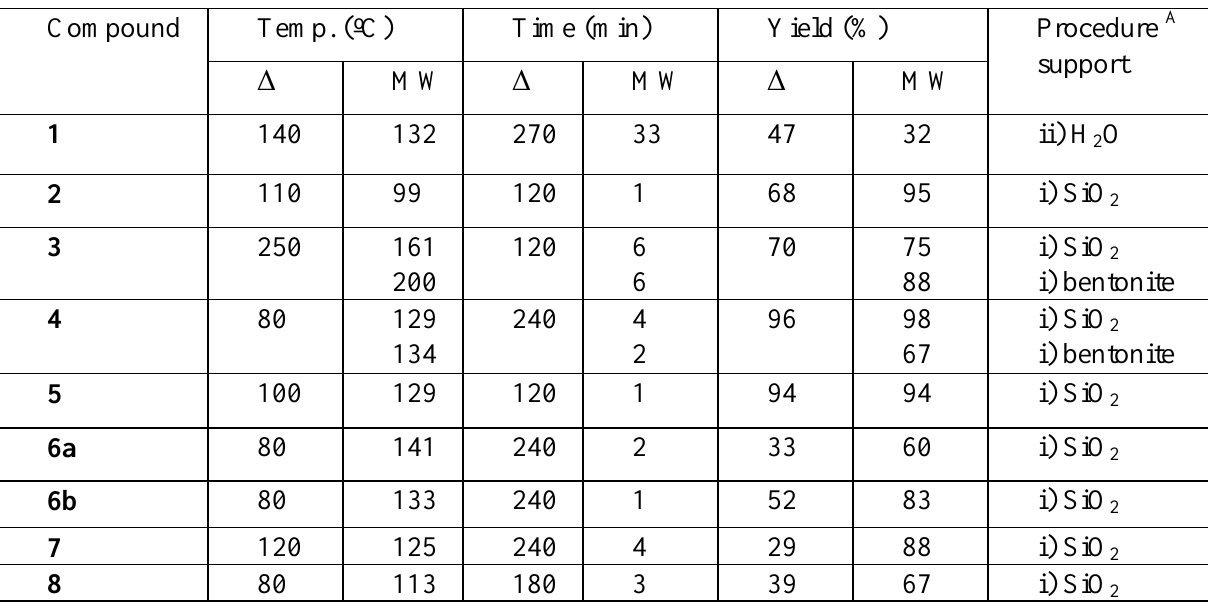
Table 1. Preparation of quinoline derivatives using a dynamic microwave power system (50%duty cycle, power level